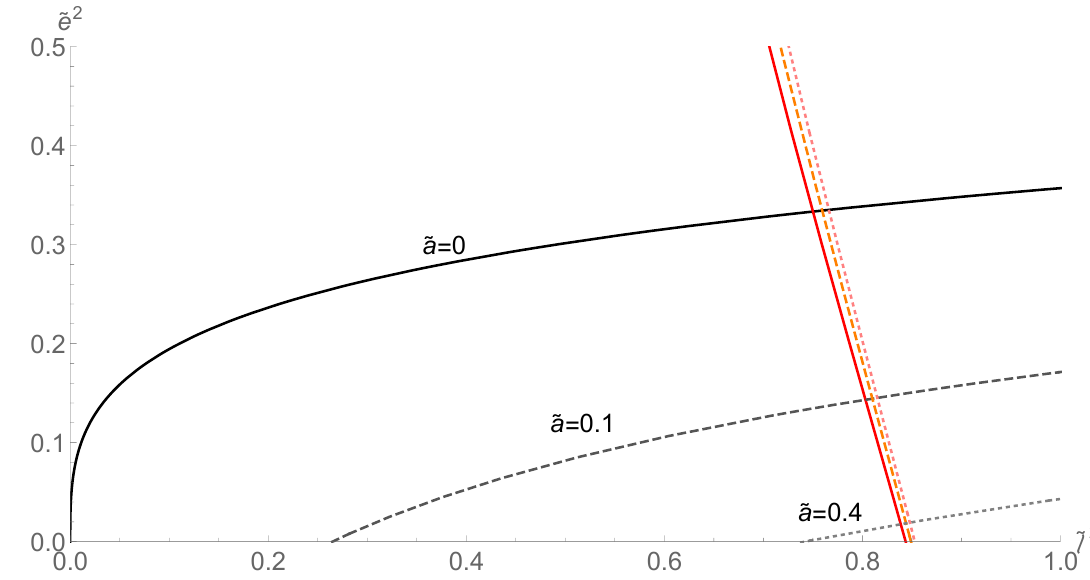
Figure 2. The allowed values of ~ ‘ and ~ e : the upper bound for ~ e from extremality is shown in black/grey, and the upper bound for ~ ‘ from the slow acceleration limit is shown in red/pink for sample values of ~ a as labelled. The upper bound for ~ a is ~ a 2 = 3 (cid:0) 2